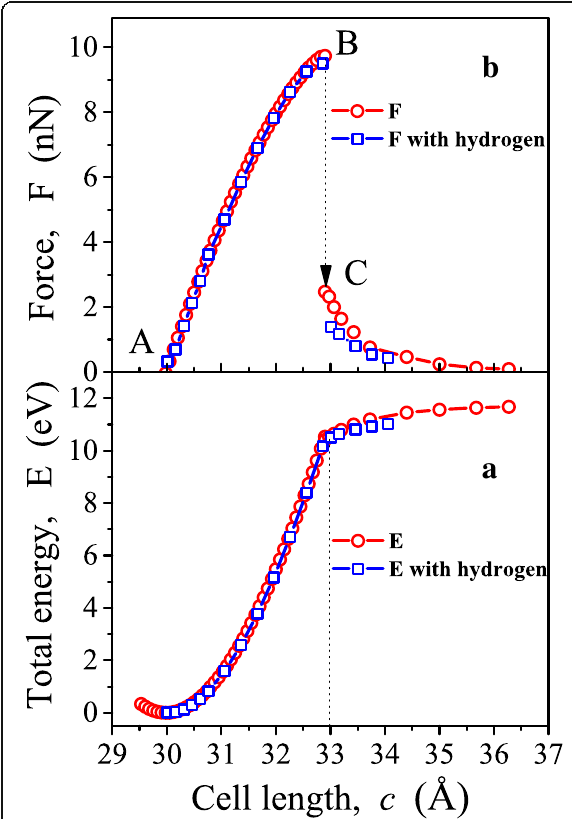
Fig. 3 The dependences of total energy, E , ( a ) and force, F , ( b ) on a cell length c , with and without hydrogen